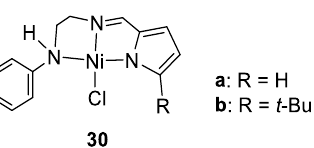
Figure 18. Pyrrolide – imine with pendant amine donor nickel complexes.